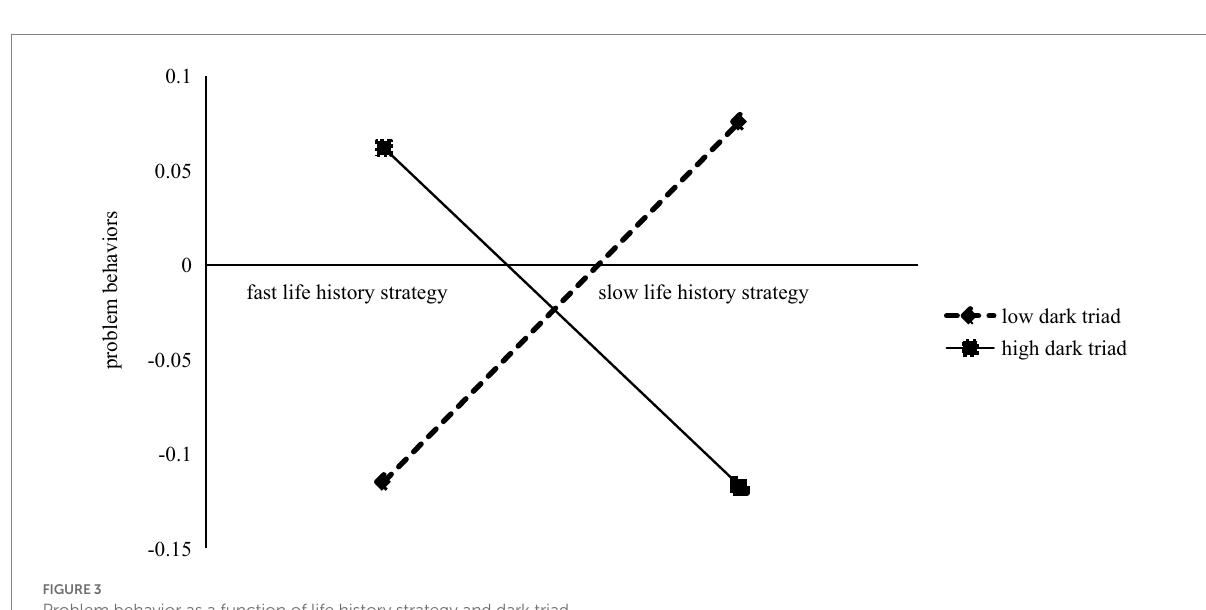
FIGURE 3 Problem behavior as a function of life history strategy and dark